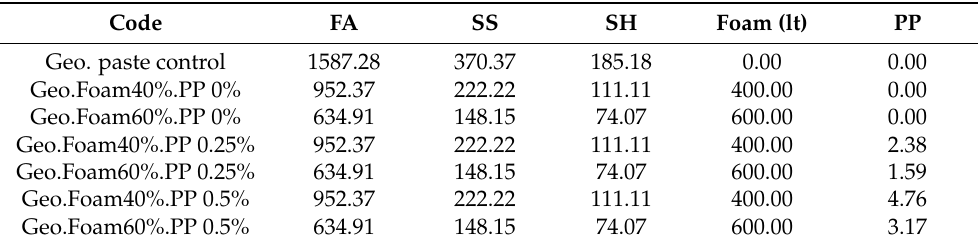
Table 2. Mixture composition of foamed geopolymer